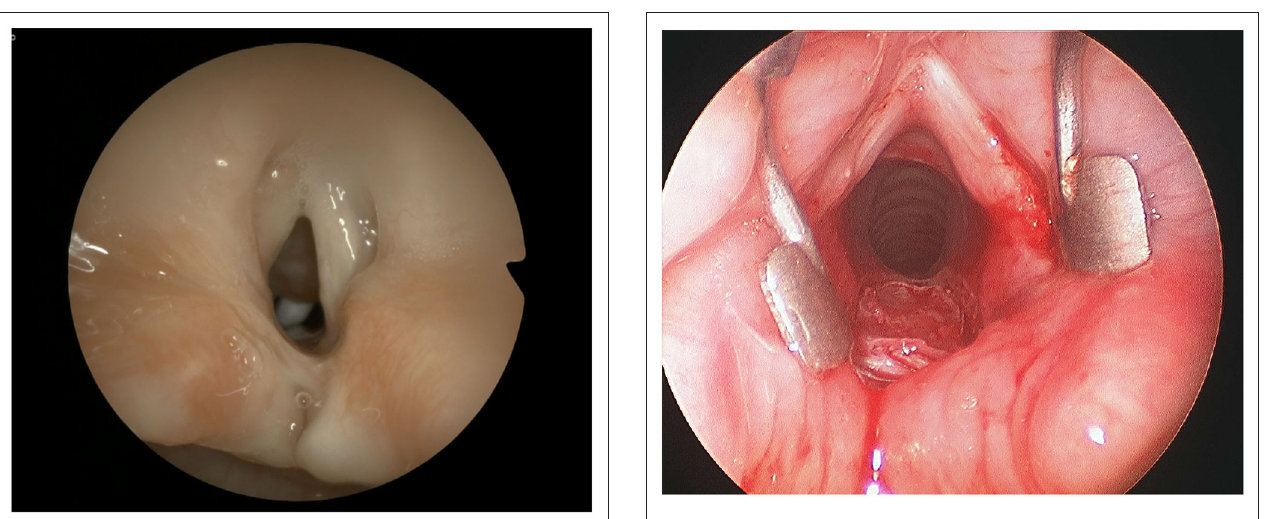
FIGURE 2 | Result after CO 2 laser left posterior cordotomy.